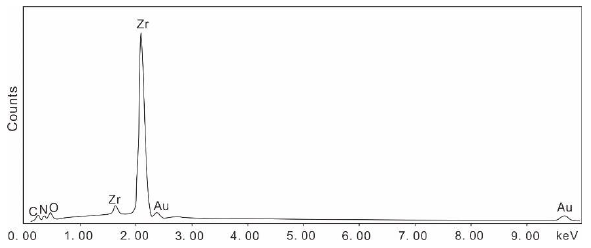
Figure 1. Representative EDS analysis of zirconia micro-nanoflakes adhered to the inner surface of gold capsule. Note that N could derive from the starting initial solutions and Au is derived from the gold capsule. Table 1. Preparation on zirconia micro-nanoflakes with high (001) facets under varied conditions. No. Initial Concentration (mol/L) Temperature (°C)